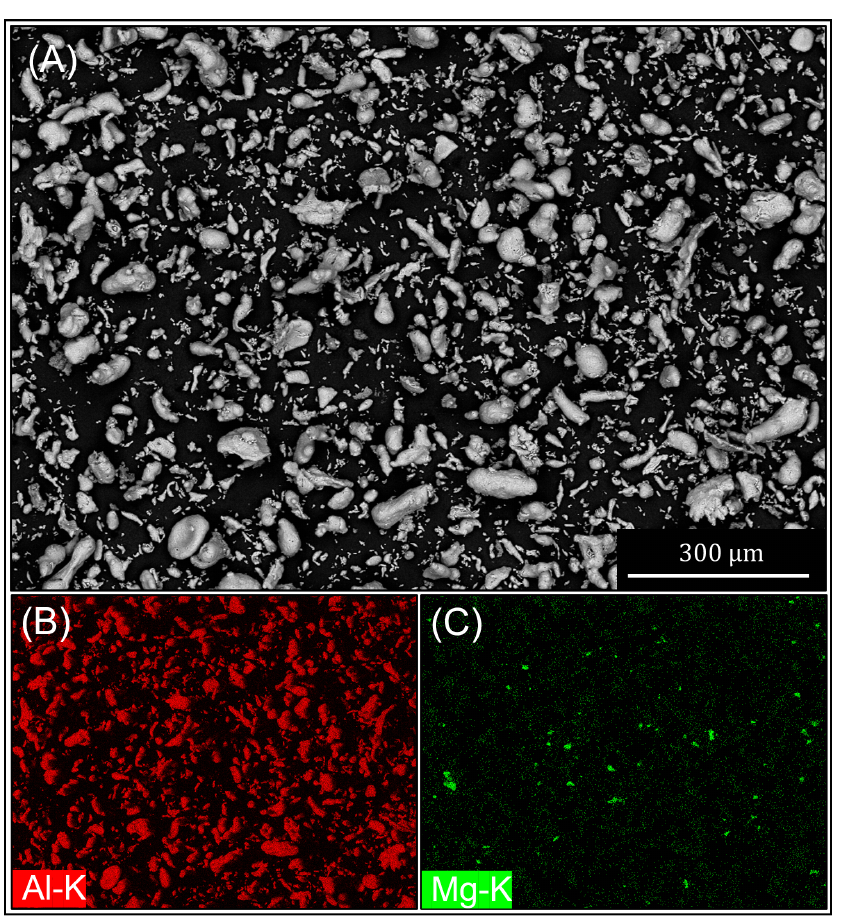
Figure 1. SEM micrograph and EDS mapping of the initial powder blend pre-nitriding: ( A ) SEM micrograph of Al-1Mg powder blend, ( B ) Al SEM-EDS map of the powder blend and ( C ) Mg SEM- EDS map of the powder blend showing the homogeneous distribution of Mg.